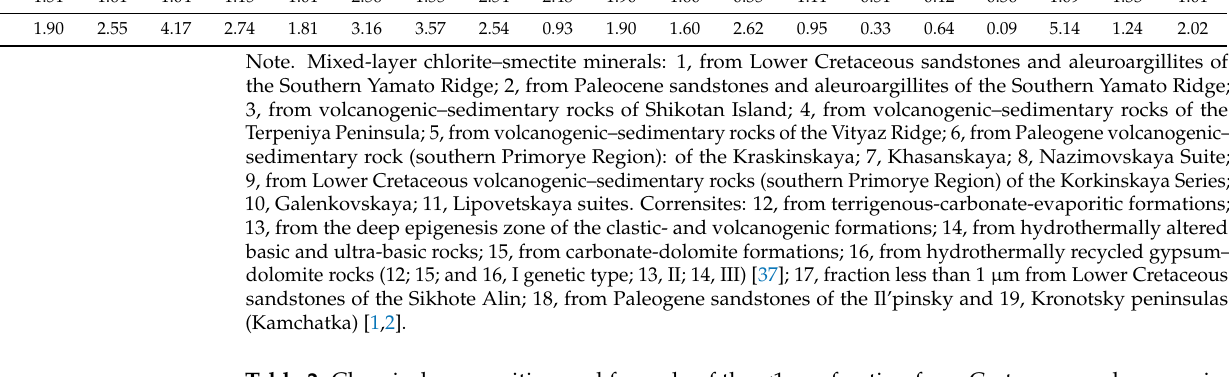
Table 2. Chemical composition and formula of the <1 µ m fraction from Cretaceous volcanogenic– sedimentary rocks of some districts of the Far East